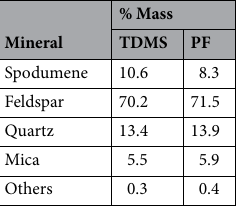
Table 1. Mineralogy of the spodumene